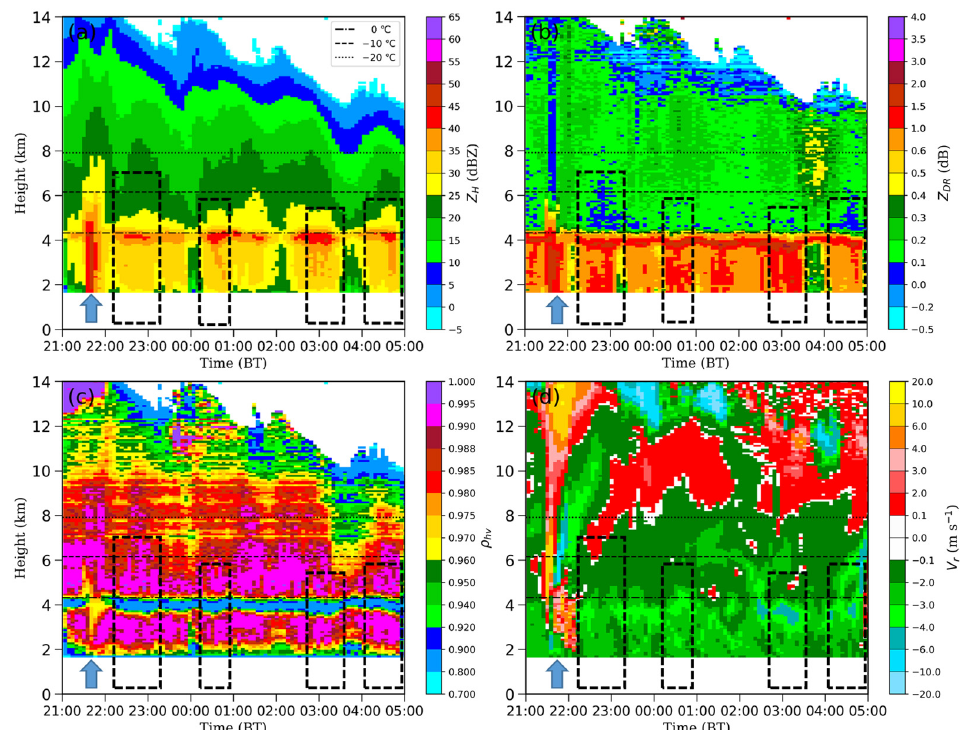
Figure 11. Height–time representation of QVPs of ( a ) Z H , ( b ) Z DR , ( c ) ρ hv , and ( d ) V r retrieved from QZ-SPOL data collected at an elevation angle of 19.5° between 2100 on 10 May and 0500 BT on 11 May 2021. Positive velocity indicates an updraft and negative velocity indicates a downdraft.